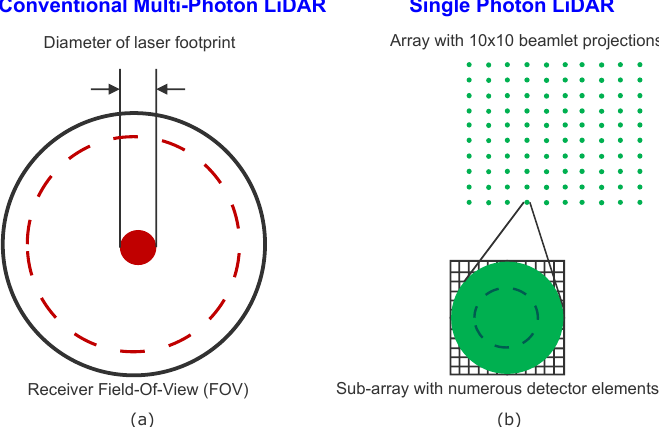
Figure 1. Typical optical receiver scenario for conventional Multi-Photon LiDAR and recent Single Photon LiDAR; ( a ) single optical receiver; ( b ) array showing 10 × 10 beamlet projections, where each beamlet projection illuminates photosensitive sub-arrays with numerous detector elements (pixelated array detector). The dashed circles indicate different possible relations of footprint size vs. receiver’s